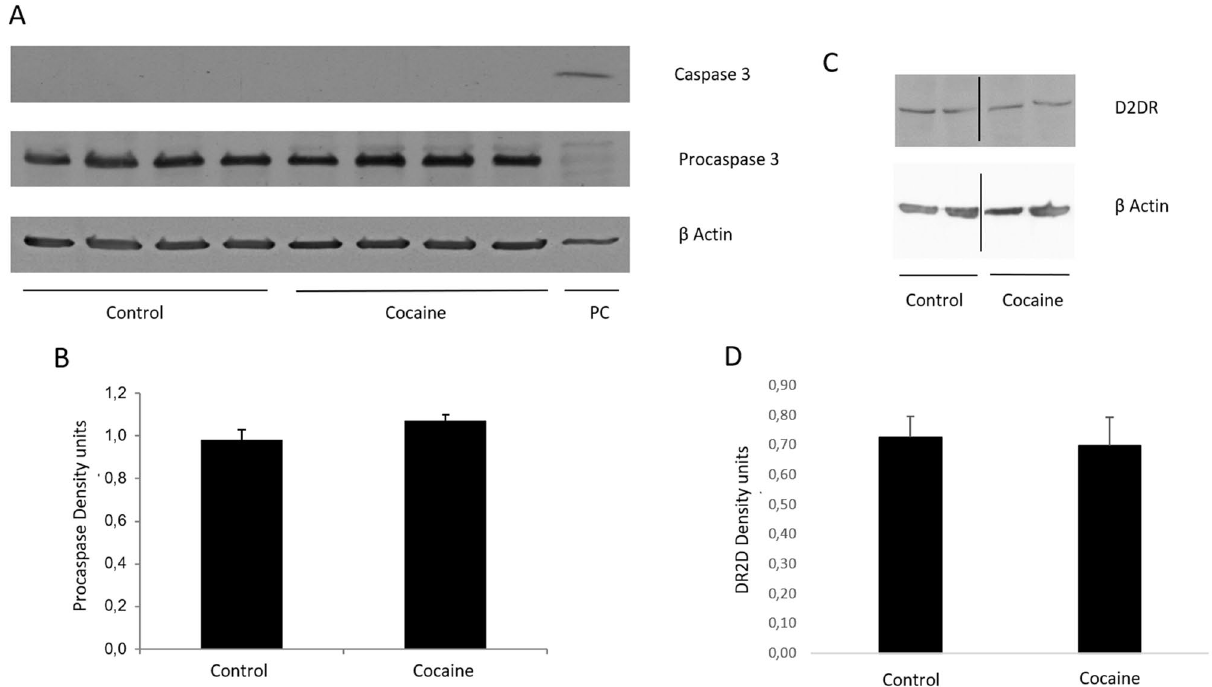
Figure 6. ( A ) Procaspase 3 (35 kDa), Caspase 3 (17/19 kDa), and β Actin (42 kDa) western blot in hippocampus. ( B ) Representation of Procaspase 3 density units in hippocampus (n = 4). ( C ) D2DR (48/51 kDa) western blot in hippocampus. Representation of D2DR density units in hippocampus (n = 7). Full-length blots are presented in Supplementary Figure 4 Samples derive from the same experiment and that gels/blots were processed in